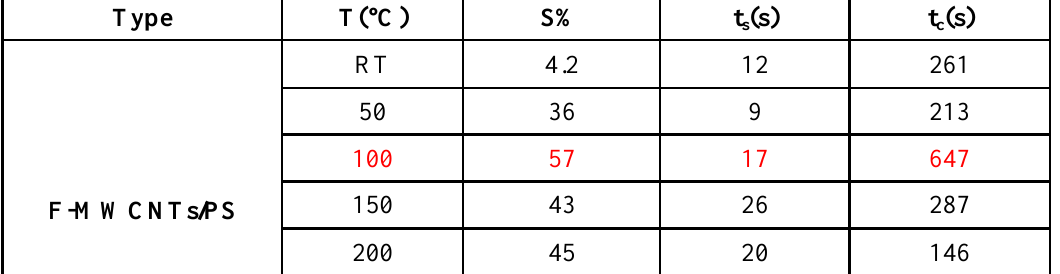
and Recovery time (t s) gas with different 2